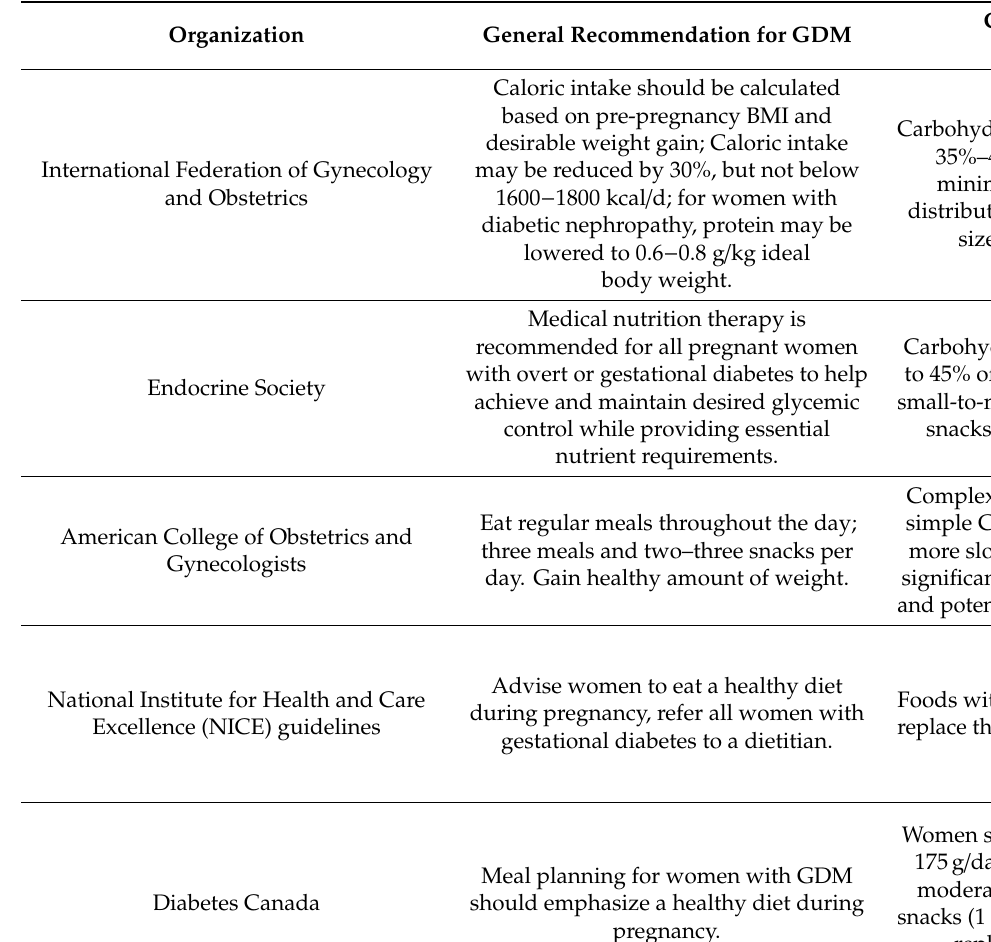
Table 1. Nutrition Recommendations for gestational diabetes mellitus